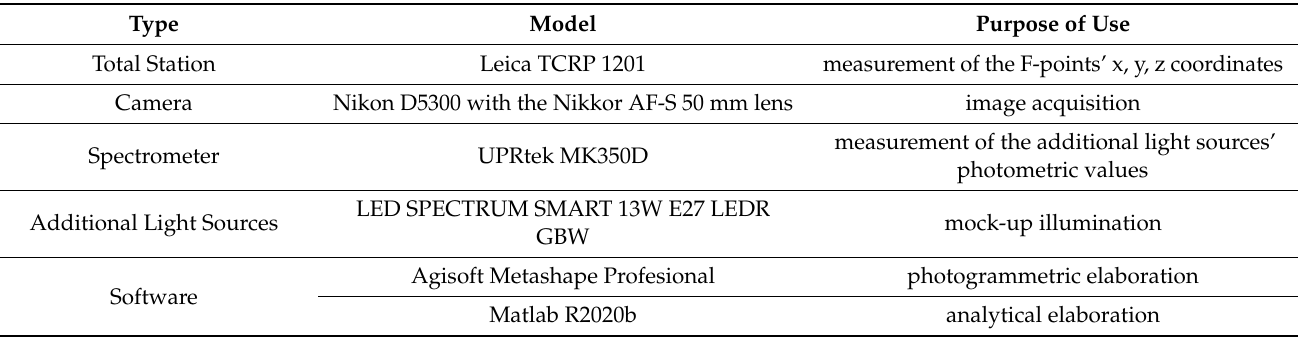
Table 1. List of tools (hardware and software) used during testing.